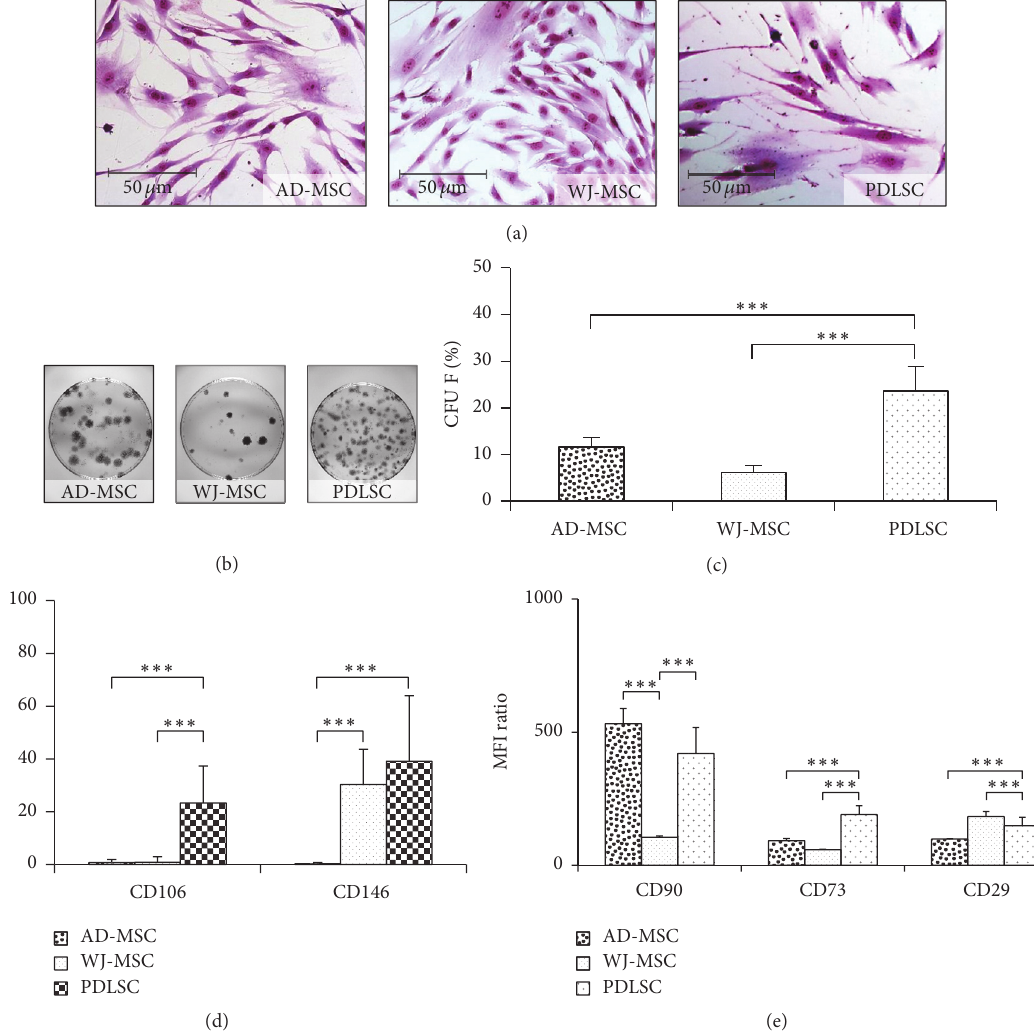
Figure 2: Heterogeneity of the different MSC samples. The morphology of the cells was demonstrated with Giemsa staining (a). The colony formingabilityofMSCswasinvestigatedon10 cmpetridishes(b).Colonyformingefficiencywascalculatedasthenumberofcoloniesdivided by the total number of seeded cells (c). The CD106 and CD146 expression in different MSC isolates determined by flow cytometry (d). The expression levels of CD90, CD73, and CD29 markers of MSC samples were determined with flow cytometry and represented as median fluorescence intensities (MFI) (e). The photos demonstrate representative samples. ∗∗∗ 𝑃 value less than